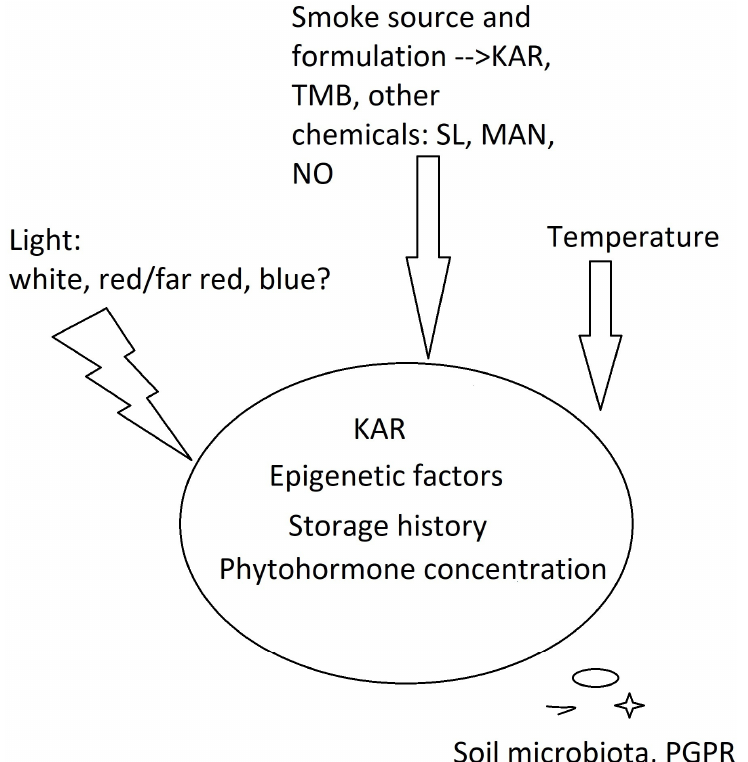
Figure 1. Interaction of KARs, other smoke chemicals and intrinsic and environmental factors on seed germination within the physiological window of KAR perception. PGPR—plant growth-promoting rhizobacteria; MAN—mandelonitriles; NO—nitric oxides; TMB—trimethylbutenolide; SL—strigolactones.